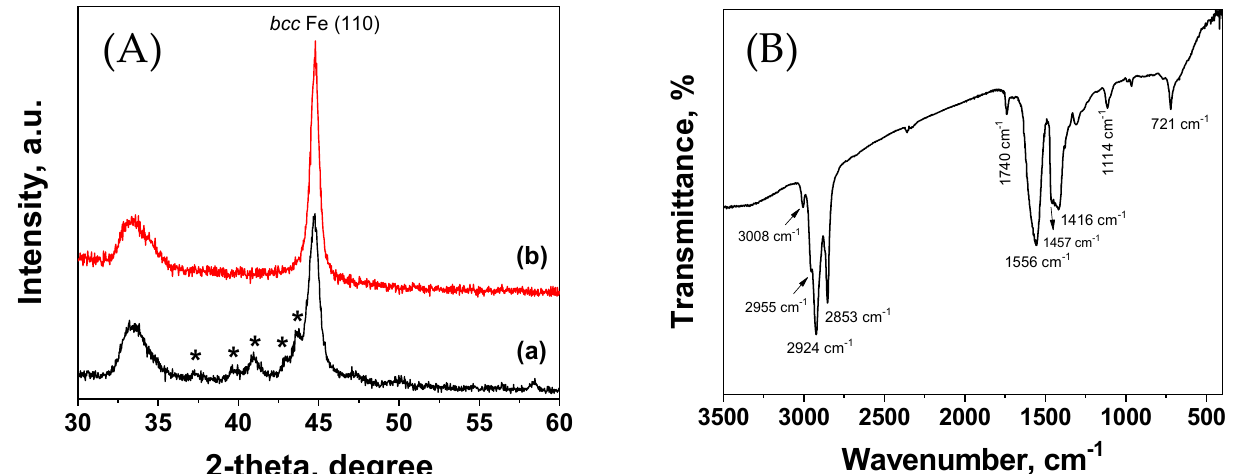
Figure 2. XRD patterns ( A ) of the core/shell Fe/Fe-oxide nanoparticles synthesized after carbonyl injection at 315 °C ( a ), and 285 °C ( b ), and the FTIR spectrum ( B ) of the particles were synthesized at 285 °C.